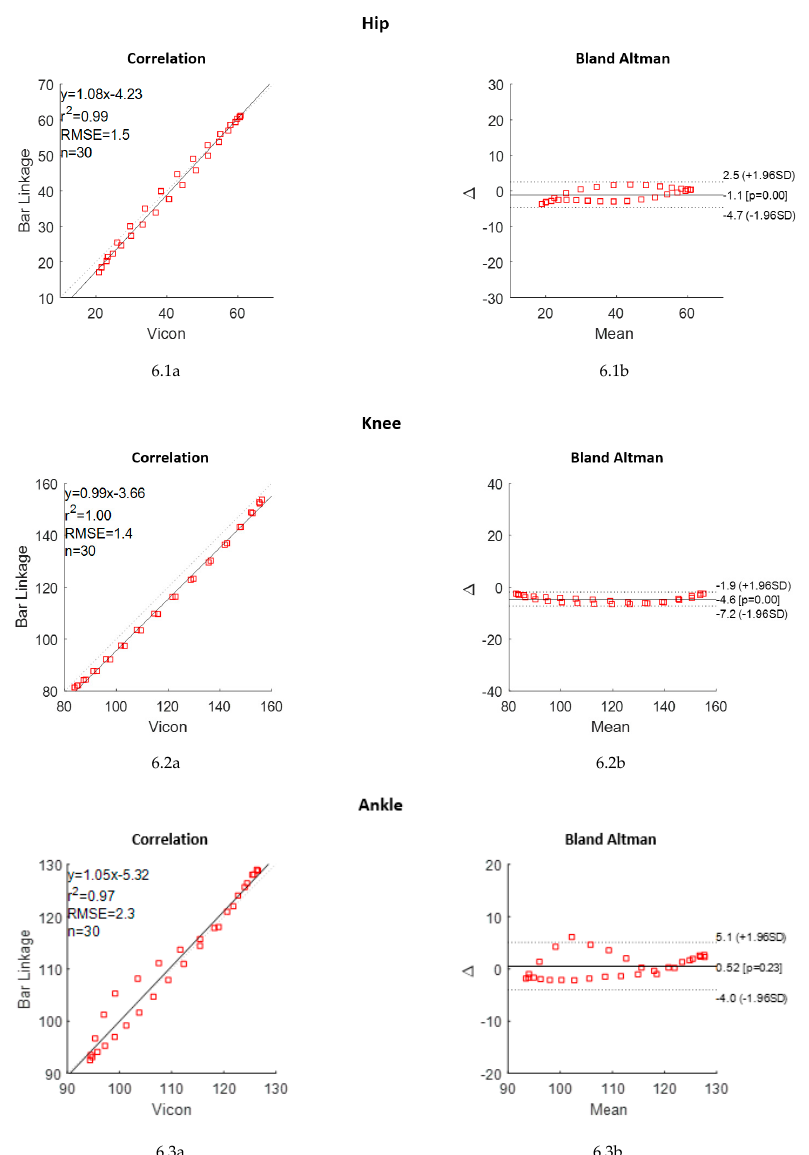
Figure 6. From top to bottom: Correlation and B&A analysis of method-specific AVCs for the hip (6.1); knee (6.2) and ankle (6.3). From left to right: Correlation plot ( a ); B&A plot ( b ). The hip, knee and ankle show a very high correlation with r 2 values of 0.99, 1, and 0.97, respectively, and RMS values of respectively 1.5, 1.4, and 2.3. The B&A plot of the ankle presents one outlier that